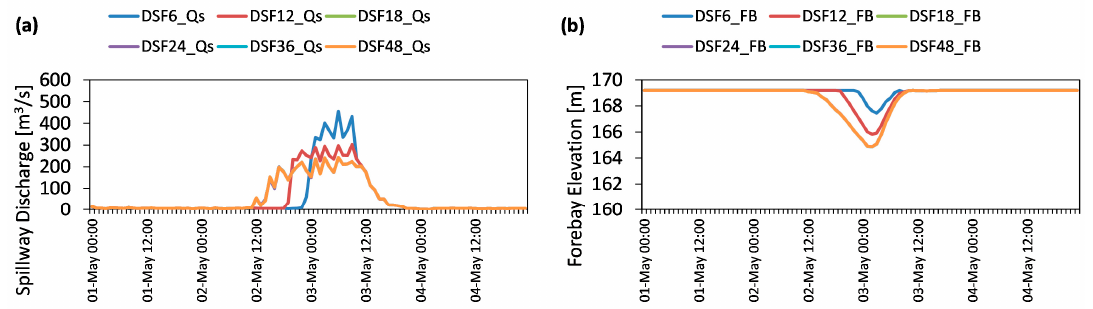
Figure 8. Comparison of closed-loop MPC forecast horizon performances with DSF (Sce-Q100a): ( a ) Spillway discharge (m 3 /s); ( b ) forebay elevation (m).